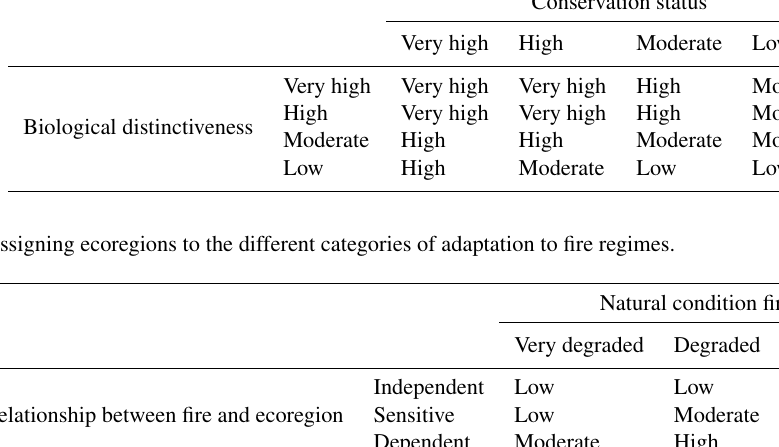
Table 5. Criteria for assigning ecoregions within biomes to the different categories in the ecological indicator.